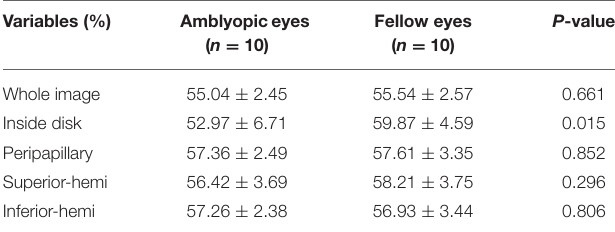
TABLE 2 | Peripapillary capillary all vessel density in amblyopic and fellow